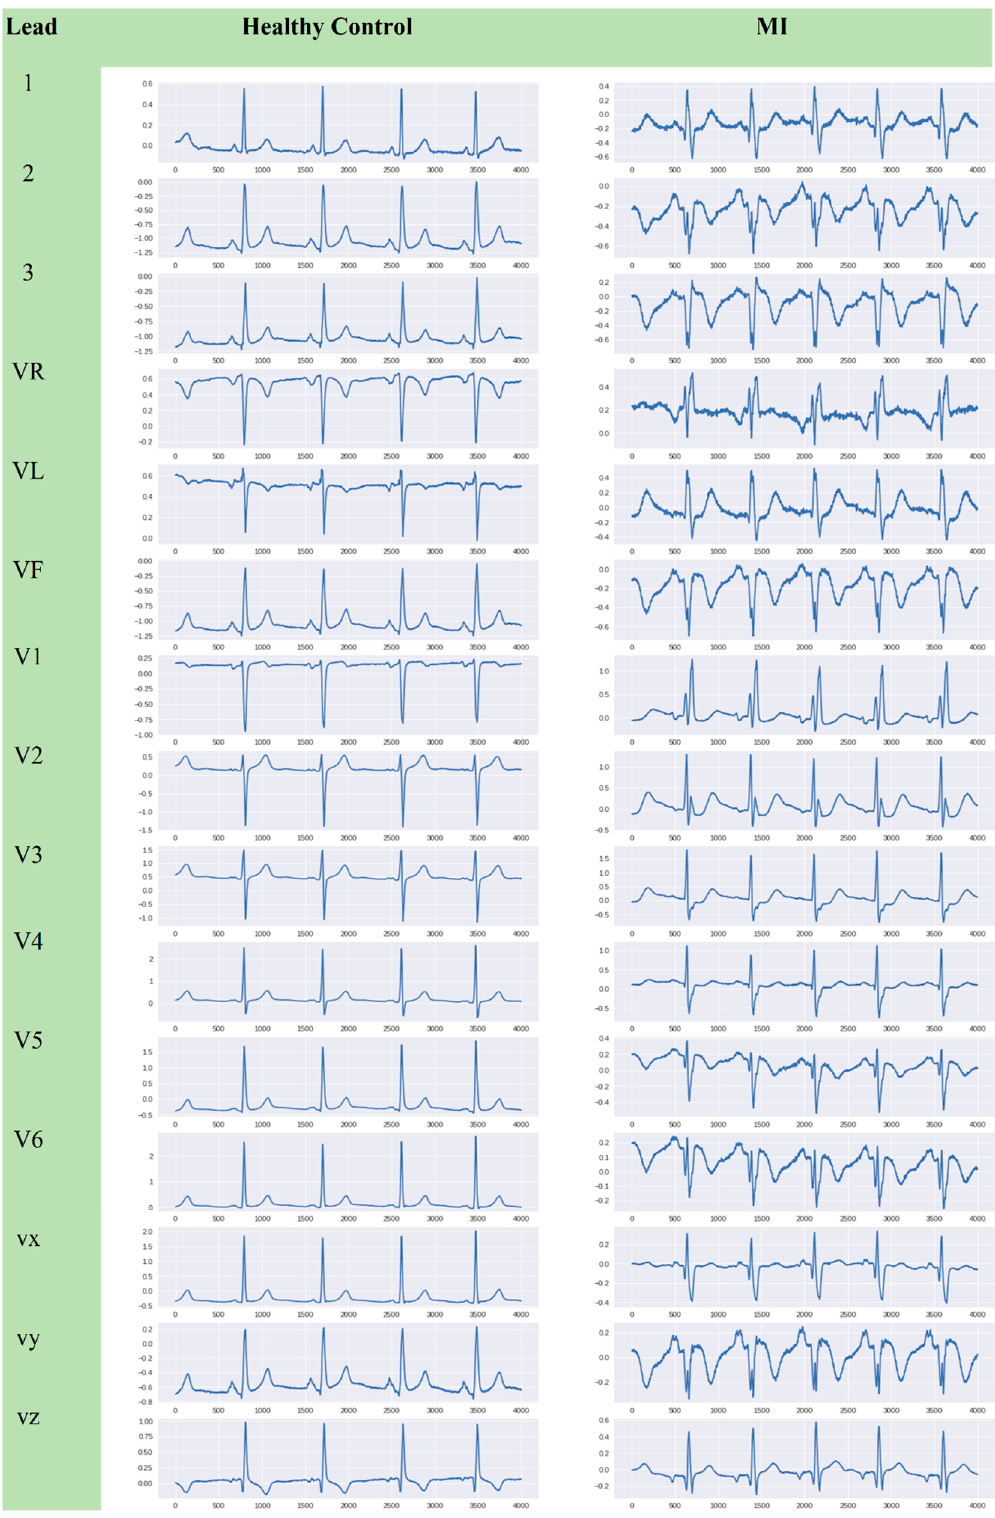
Figure 2. The ECG window sized segmentation in each 4 s.